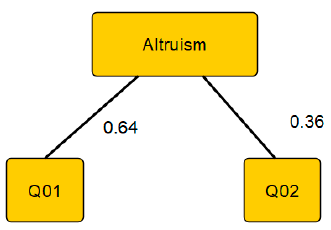
Figure 5. The subtree altruism.